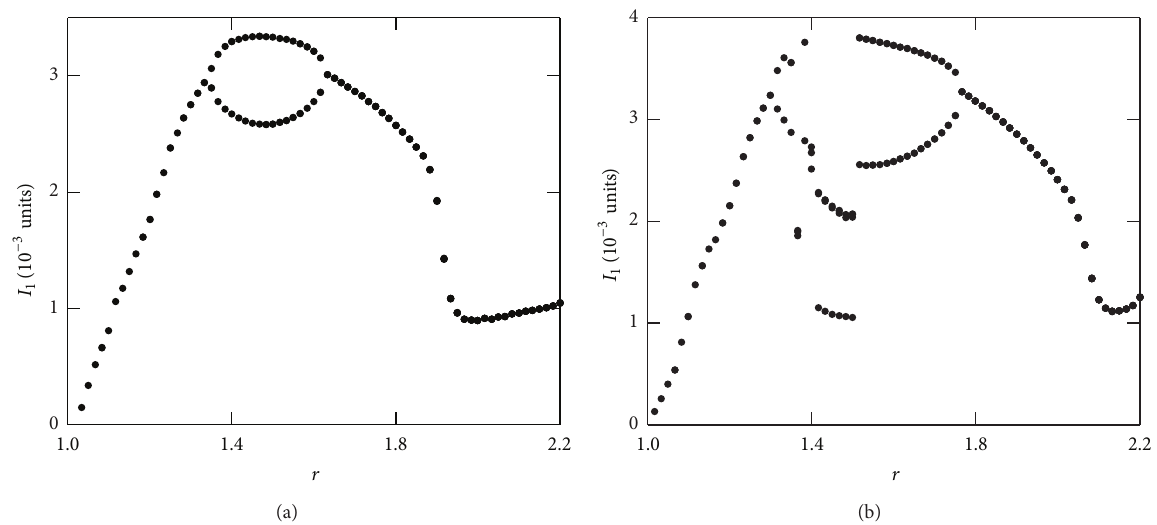
Figure 4: Bifurcation diagram of the mode intensity for two values of ion pairs versus the pumping strength 𝑟 .